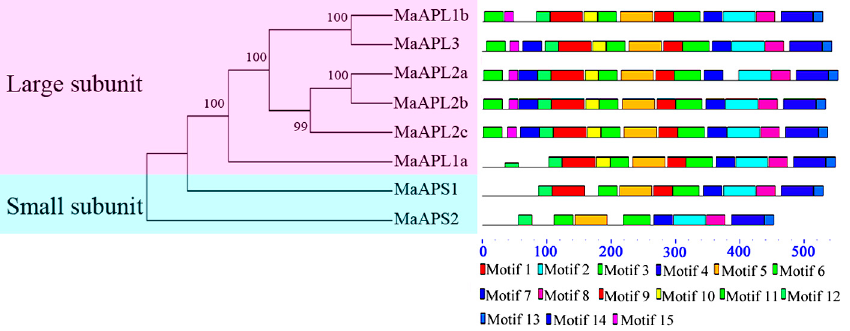
Figure 3. Phylogenetic and motif analyses of MaAGPase proteins. All proteins were identified by MEME database with the complete amino acid sequences of each MaAGPase identified. MaAGPases were classified into large and small subunits based on their phylogenetic relationship.